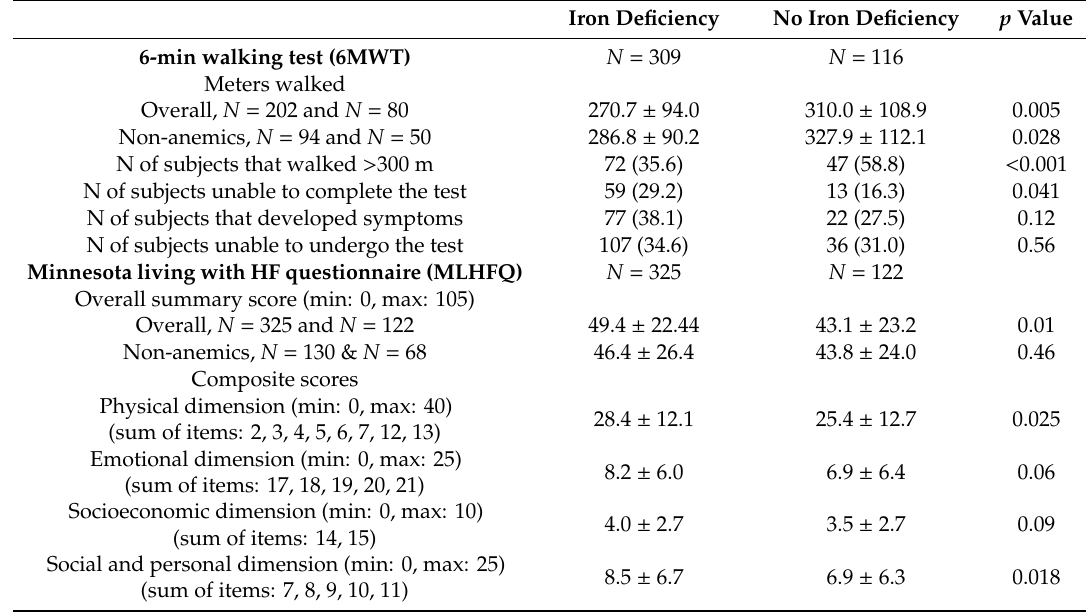
Figure 1. (a) Functional capacity, measured with 6-min walking test (6MWT), according to iron deficiency. (b) Quality of life, measured with Minnesota Living with Heart Failure Questionnaire (MLHFQ), according to iron deficiency. Table 2. Functional capacity and quality of life according to iron deficiency.